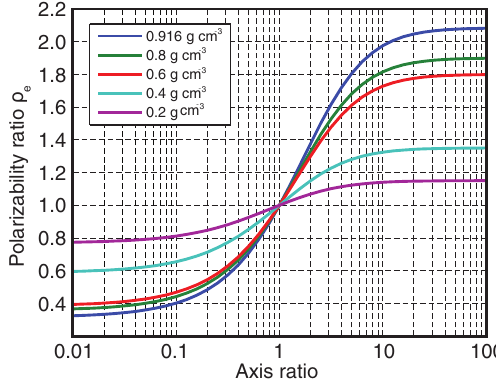
Figure 2. Dependencies of polarizability ratio ρ e on axis ratio of a spheroid for different apparent densities of ice. The figure is adopted from Myagkov et al.